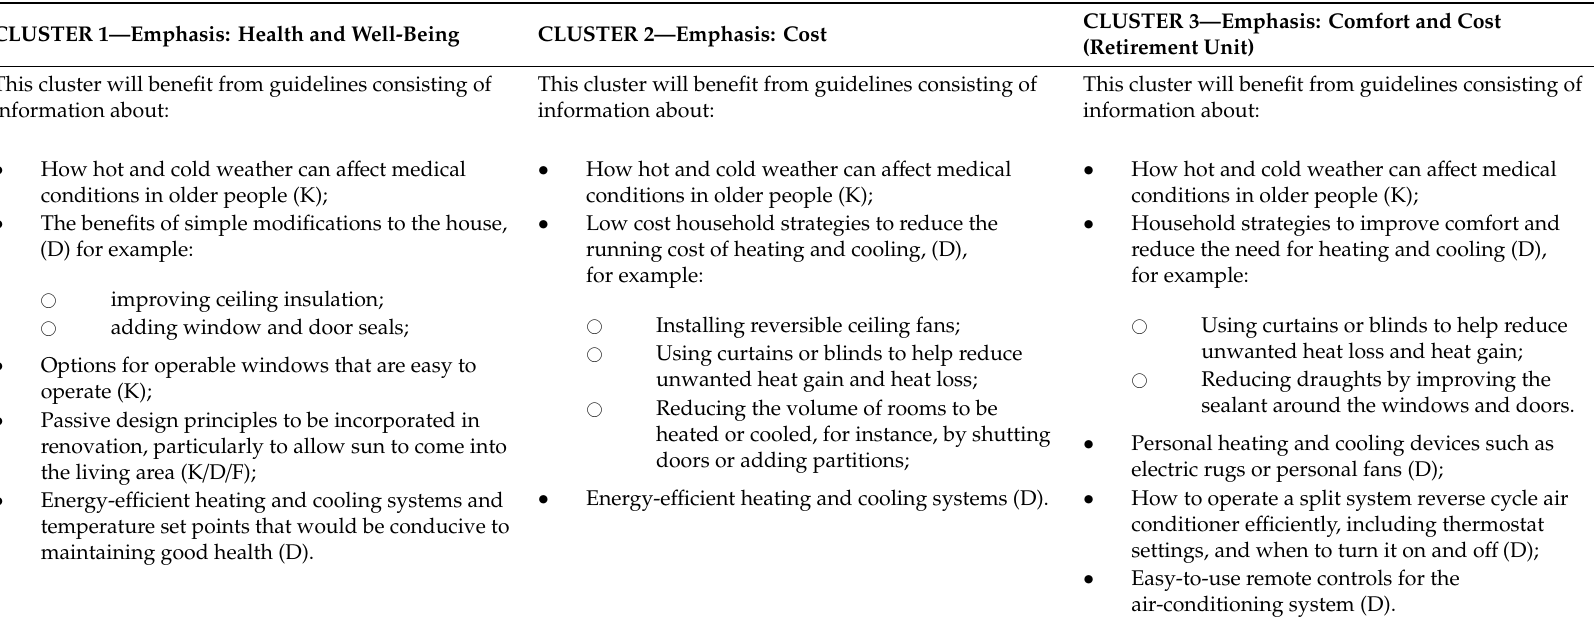
Table 5. Important points to be addressed in the thermal comfort